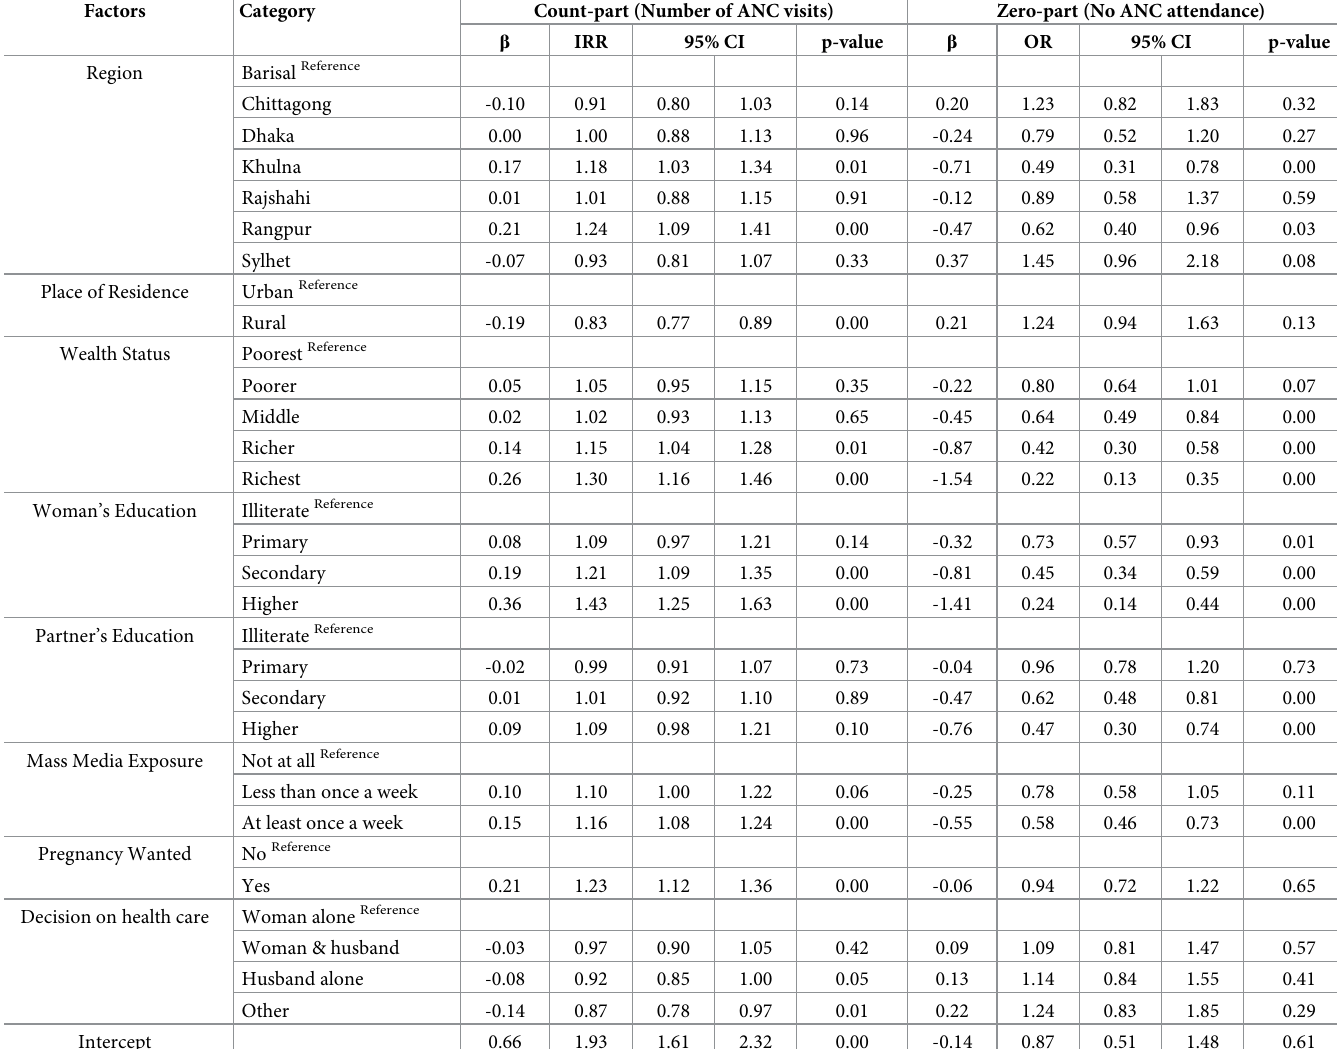
Table 6. Estimated regression coefficient ( β ), incidence rate ratio (IRR) of having ANC visits and odds ratio (OR) of not attending any ANC visit with their 95% CI and p-values from the hurdle negative binomial regression with random intercept at both count- and zero-part (MHNBR.ERE) models. Factors